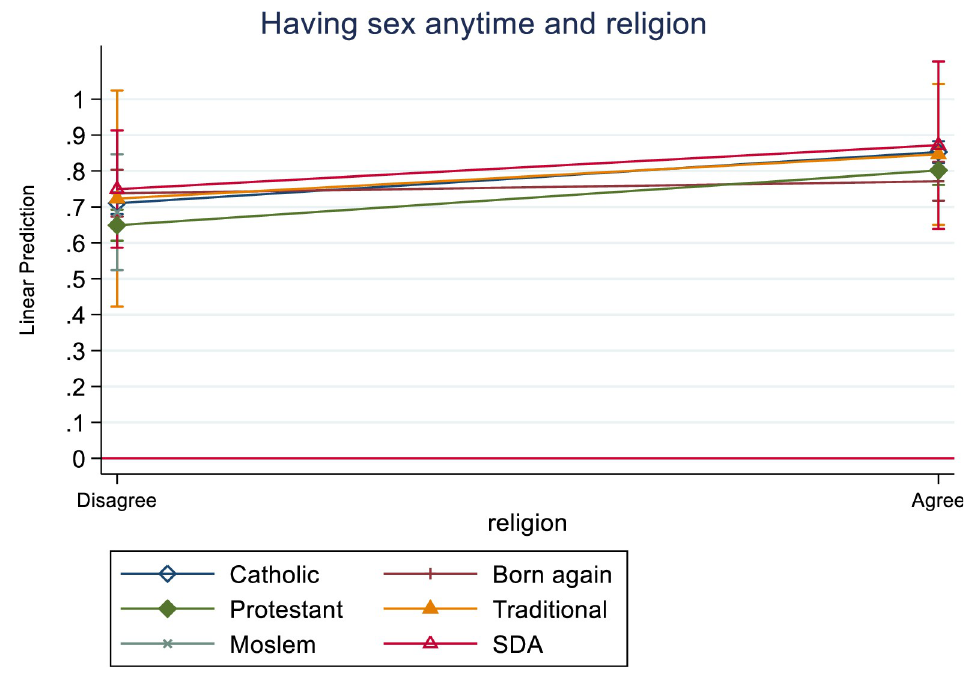
Fig 1. Marginal effects of a man having sex anytime with his wife and religion on justification of physical violence against women.